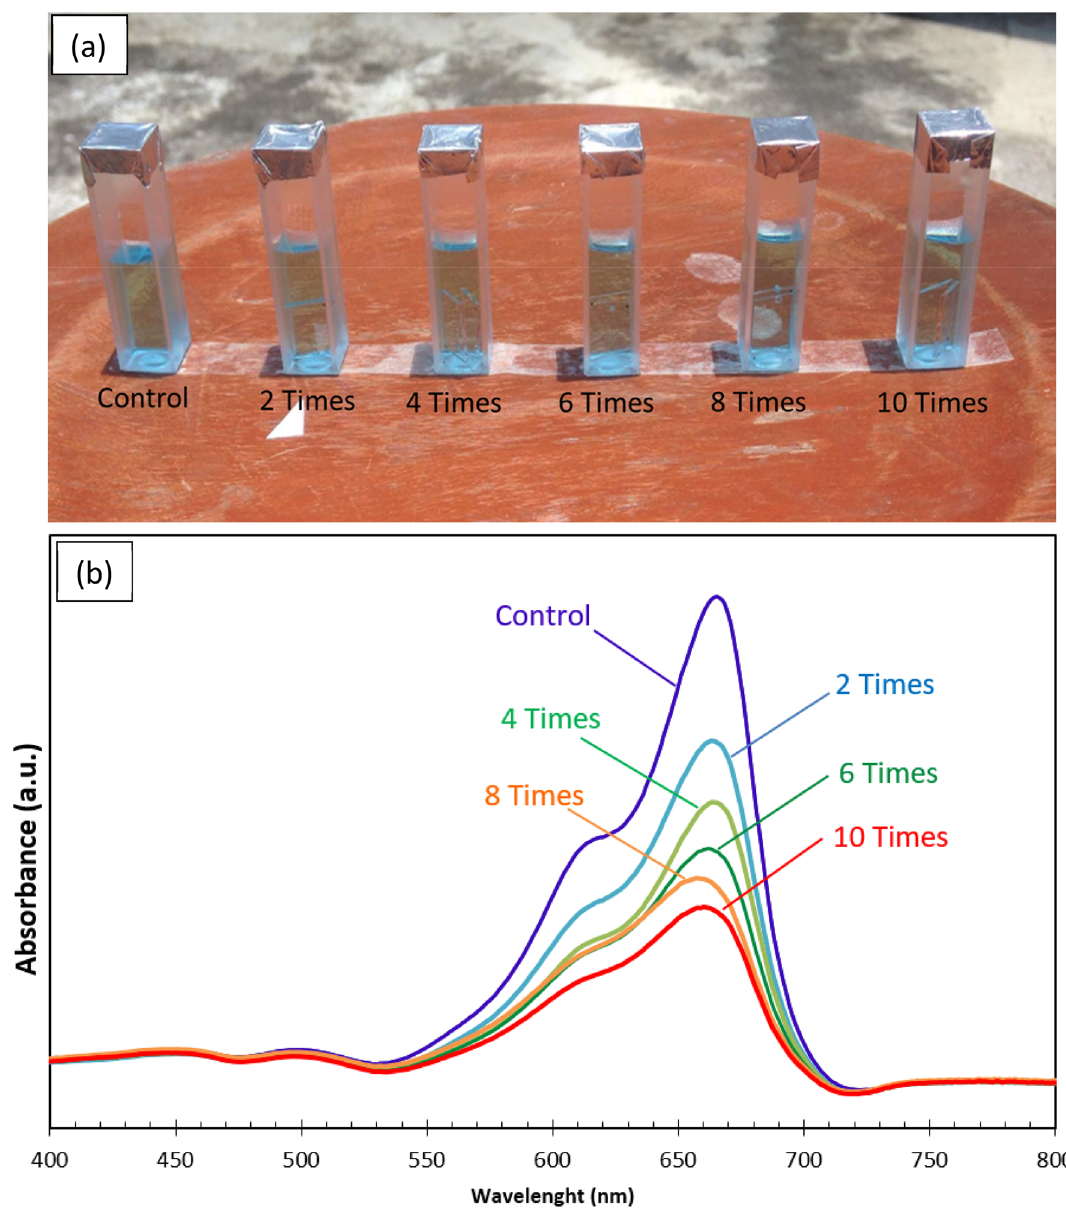
Figure 9. ( a ) photographs of the methylene blues after exposed in sunlight for 1 h ( b ) Variation of absorbance spectrum of methylene blue with